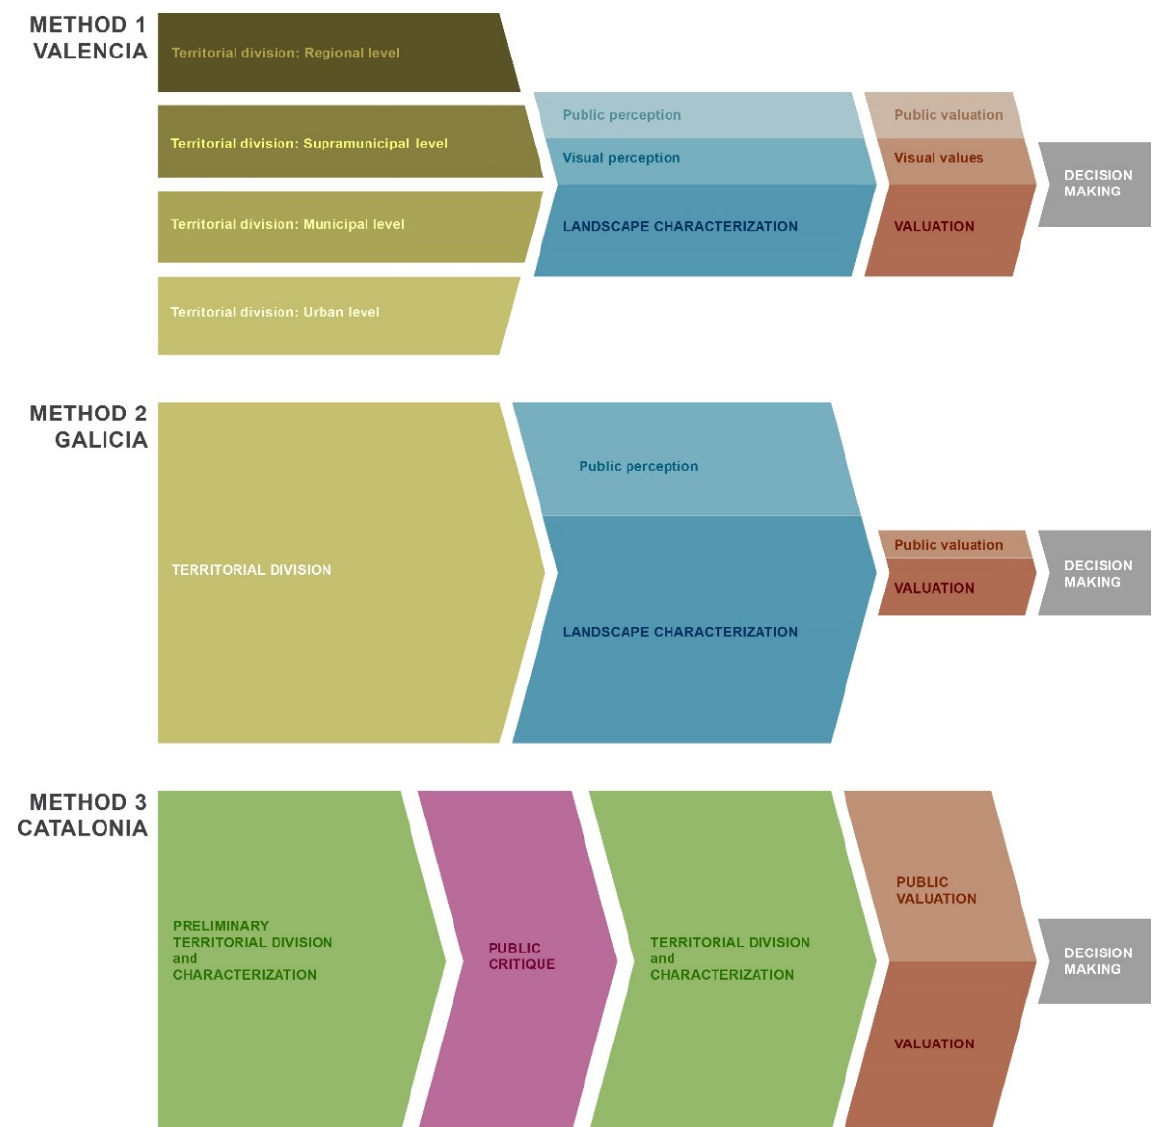
Figure 1. Diagram of landscape analysis methods.